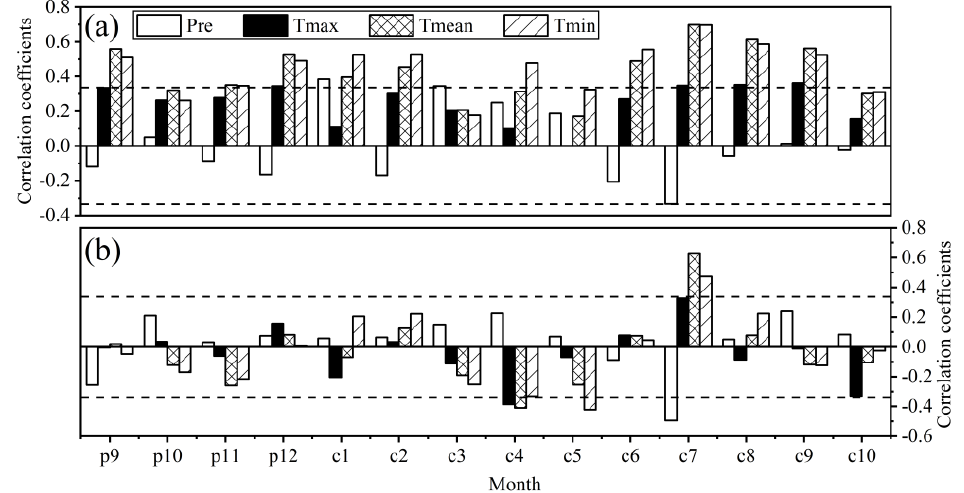
Figure 3. Correlation coefficients between tree ring width (TRW) chronology and climatic factors (monthly mean temperature, monthly mean maximum/minimum temperature, and monthly precipitation) for the original ( a ) and first–differenced ( b ) data.